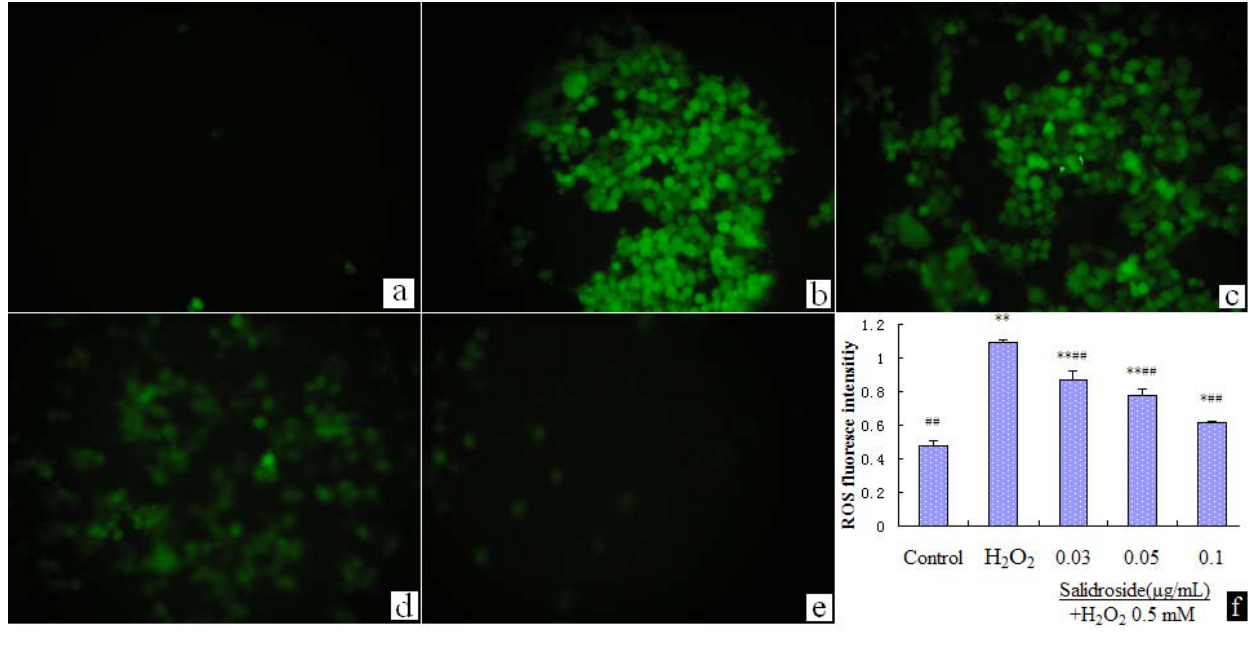
O -induced ROS elevation (Recorded by inverted 2 2 O ; ( c ). 0.03 μ g/mL 2 2 O ; ( e ). 0.1 μ g/mL salidroside + H O ; 2 2 2 2 O as described in 2 2